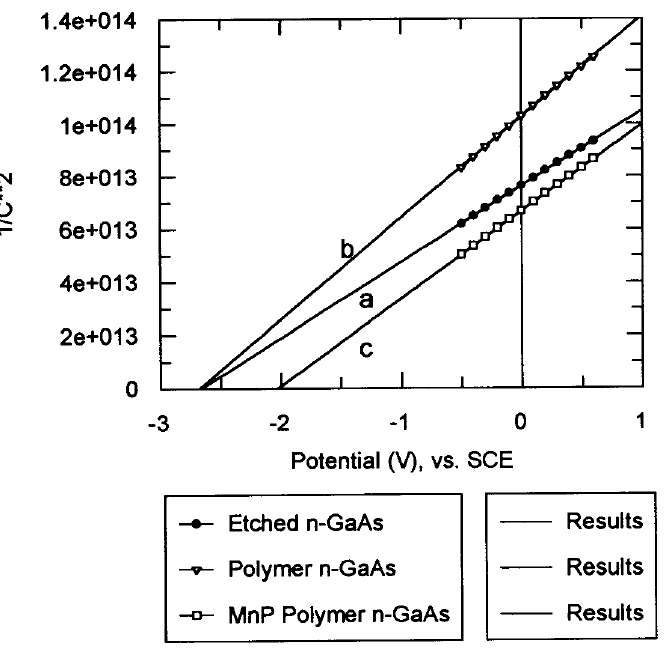
FIGURE 3 Effect of n-GaAs surface modification on the value of its flat-band potential, after annealing each electrode, using (a) unmodified, (b) polymer-modified and (c) MnP = polymer-modified electrodes. All measurements were conducted in the dark in water = LiClO 4 = Fe(CN) 3 (cid:2)